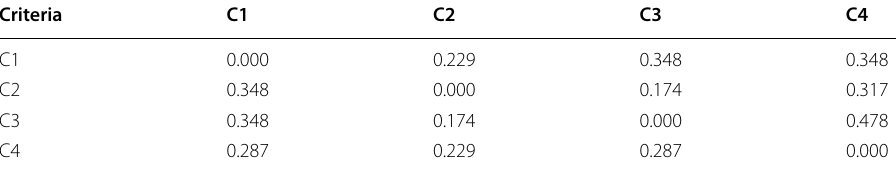
Table 18 Normalized relation matrix for the equity-based crowdfunding alternative Criteria